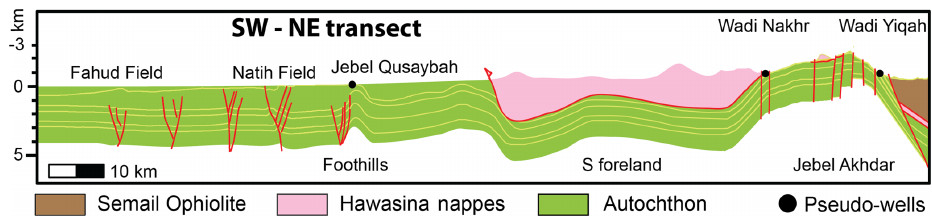
Figure 2. Structural transect used for modeling the Jebel Akhdar Dome and its southern foreland (Al-Lazki et al., 2002; Filbrandt et al., 2006; Searle, 2007; Warburton et al., 1990). Highlighted are the locations of the pseudo-wells (black circles) in Wadi Nakhr, Wadi Yiqah, and at Jebel Qusaybah, Adam Foothills, which were used for model